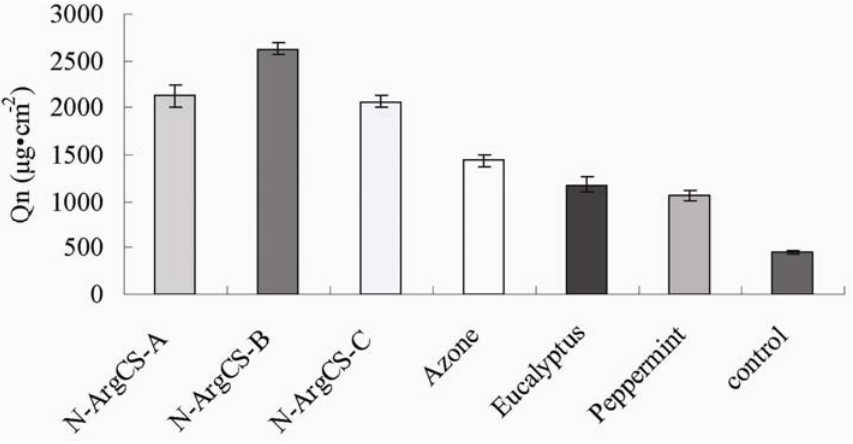
Figure 5. The accumulated transportation of adefovir across mice skins with various enhancers after 12 h (n =